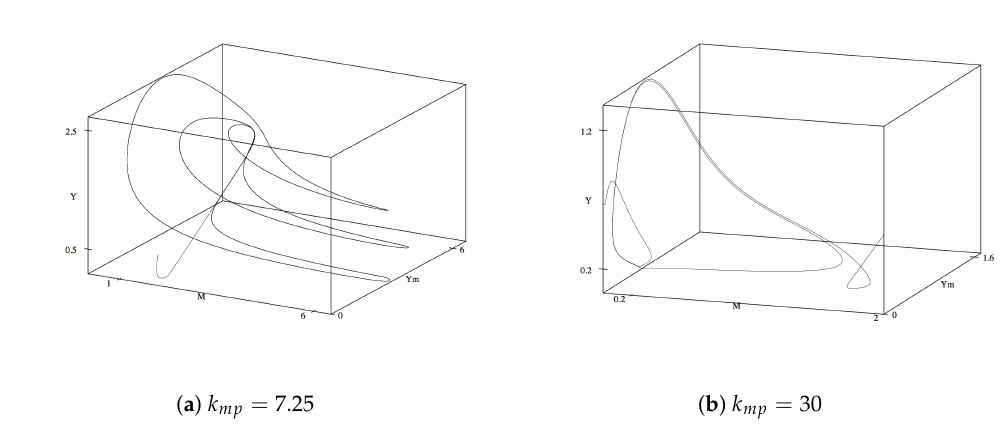
Figure 5. Phase plane diagrams for ( M , Y m , Y ) for varying k mp .